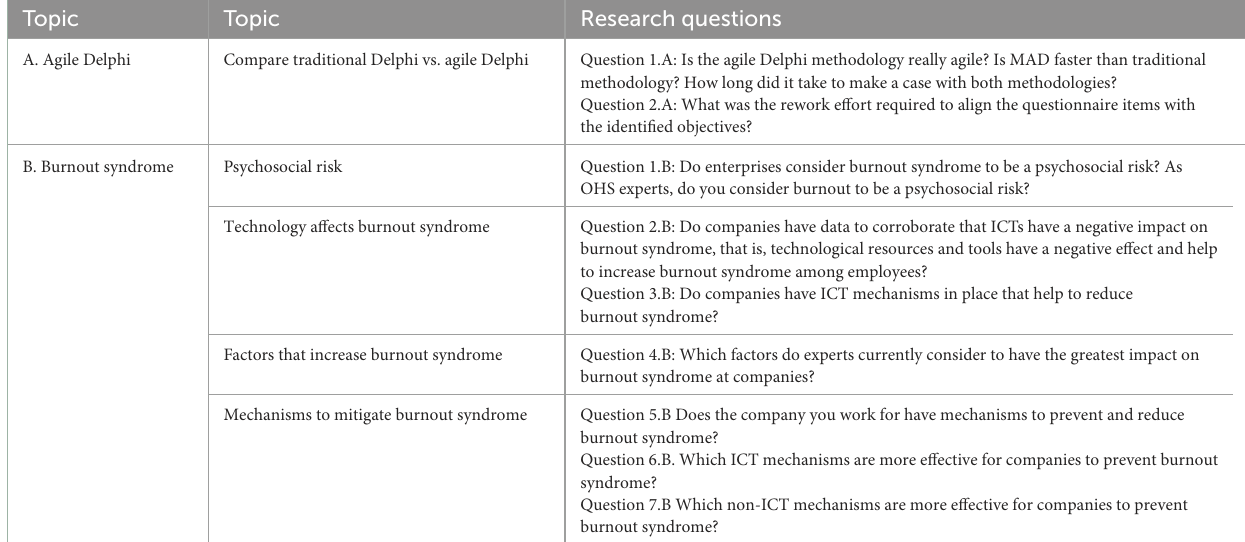
TABLE 9 Research questions. Topic